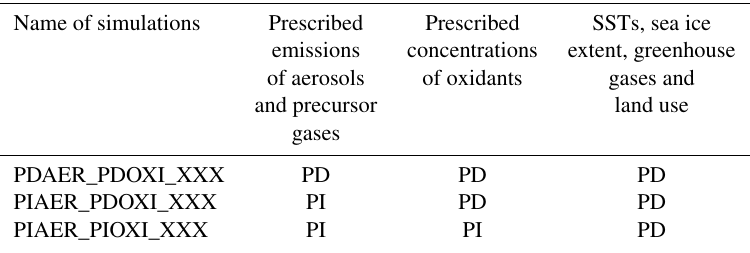
Table 3. Overview of the prescribed precursor and aerosol emissions and prescribed oxidant concentrations used in the three different simulations that were carried out for each modification to the default model